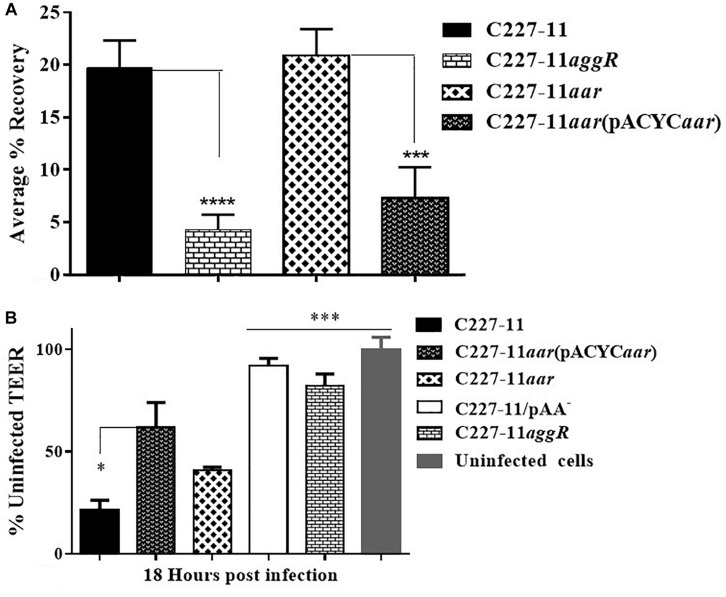
Adherence and trans-epithelial electrical resistance (TEER) of wild-type C227-11 and mutant C227-11aar. Adherence of C227-11 and mutants C227-11aggR, C227-11aar, and complemented strain C227-11aar(pACYC184aar) to T84 cell monolayers after 3 h incubation (A). Polarized T84 cells were infected with EAEC strain C227-11, mutants C227-11/pAA–, C227-11aggR, C227-11aar, and C227-11aar(pACYCaar) (B). 3 h after the addition of bacteria, the infection was terminated by aspiration of the apical compartment medium and addition of fresh medium containing Gm. TEER was measured 18 h after infection and reported as percent of the initial value. The data represent an average of two or three separate experiments with each done in triplicate. Error bars indicate one standard deviation of the mean adherence *p < 0.05, ∗∗
p < 0.01, ∗∗∗p < 0.001 and *⁣*⁣**p < 0.0001 indicate comparison between C227-11, mutants, and complemented mutants as determined by ANOVA with Tukey’s post-test.